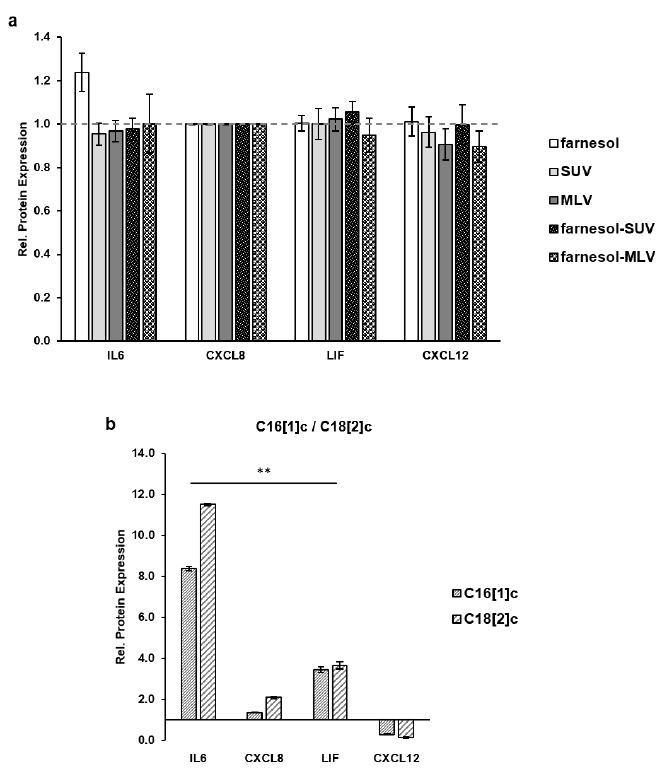
Figure 4. FFAs, but not nanovesicles, affect the inflammatory protein expression. ( a ) SkMs were left untreated or treated with farnesol, SUV, MLV, farnesol-SUV, or farnesol-MLV for 24 h; ( b ) SkMs were treated with FFA C16[1]c or C18[2]c or left untreated for 48 h. SkM cell extracts were subjected thrice to multiplex protein quantification. The relative protein expression was obtained by comparing the level of each marker in treated cells to its expression level in untreated cells (no farnesol or liposomes in a and no fatty acids in b ), which was set to 1 (dashed gray lines in a , b , respectively). The mean values ± SD from three independent experiments are presented (Supplementary Figure S6). Statistical significance was calculated using one-way ANOVA with Bonferroni’s multiple comparison test. p ≤ 0.01 (**).